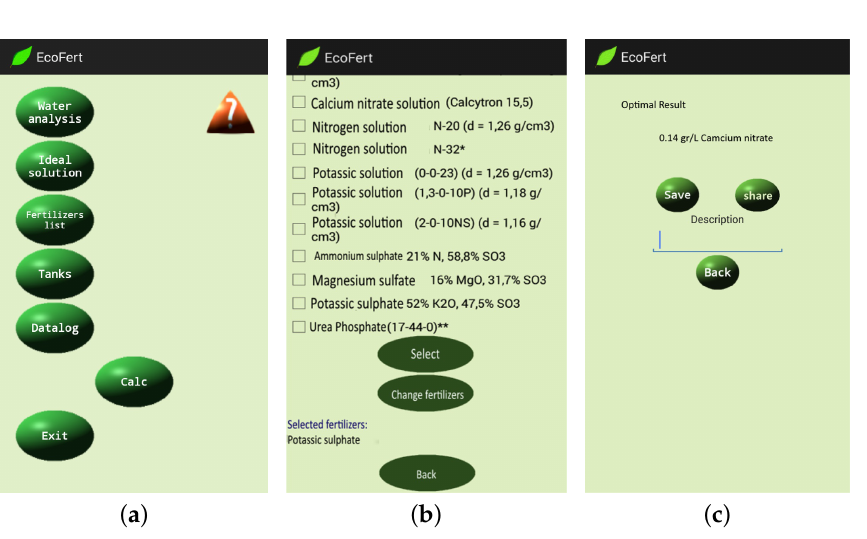
Figure 15. EcoFert: ( a ) Main menu; ( b ) Interface with list of fertilizers that user can choose; ( c ) Interface with the ideal